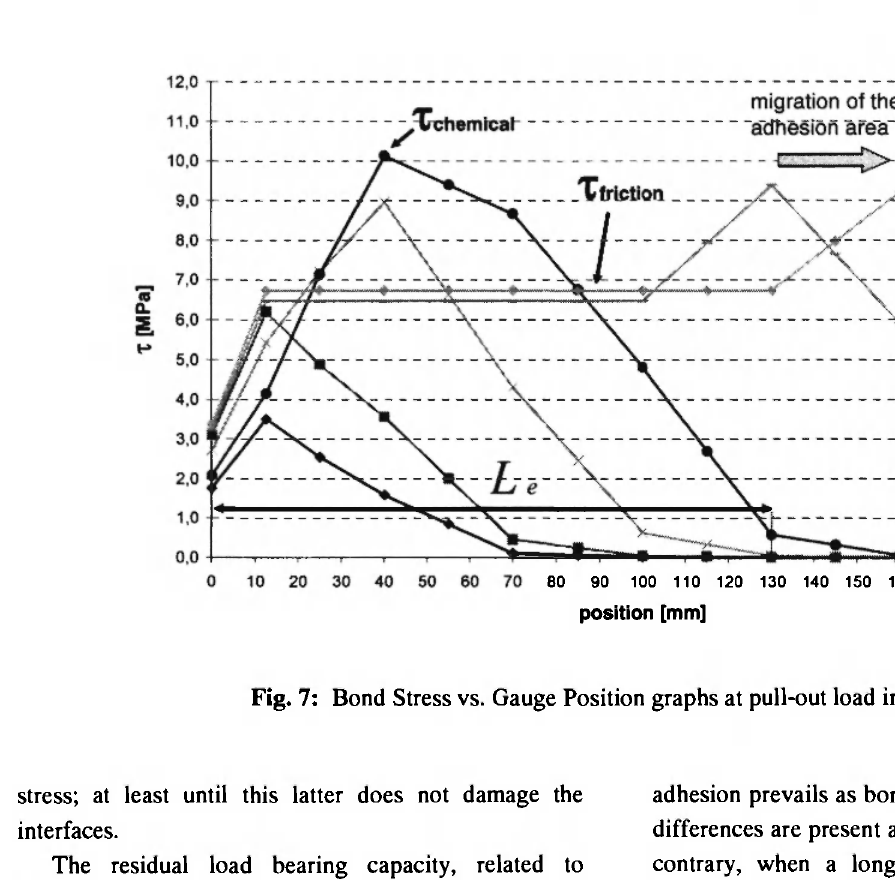
stress; at least until this latter does not damage the